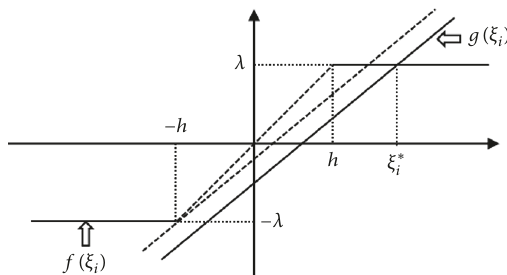
) = 𝑓(𝜉 ∗ ) , 𝜉 ∗ ≥ ℎ,𝜉 ∗ 𝑖 𝑖 𝑖 is a 𝑖